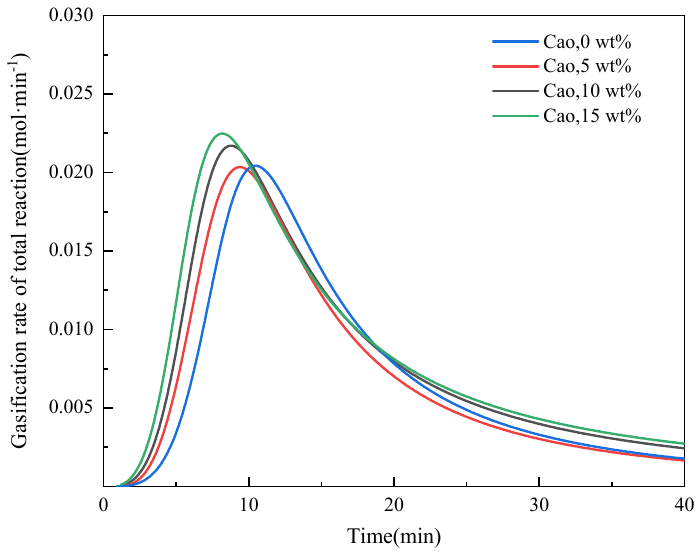
Figure 4. Effect of the added amount of CaO on the gasification rate.